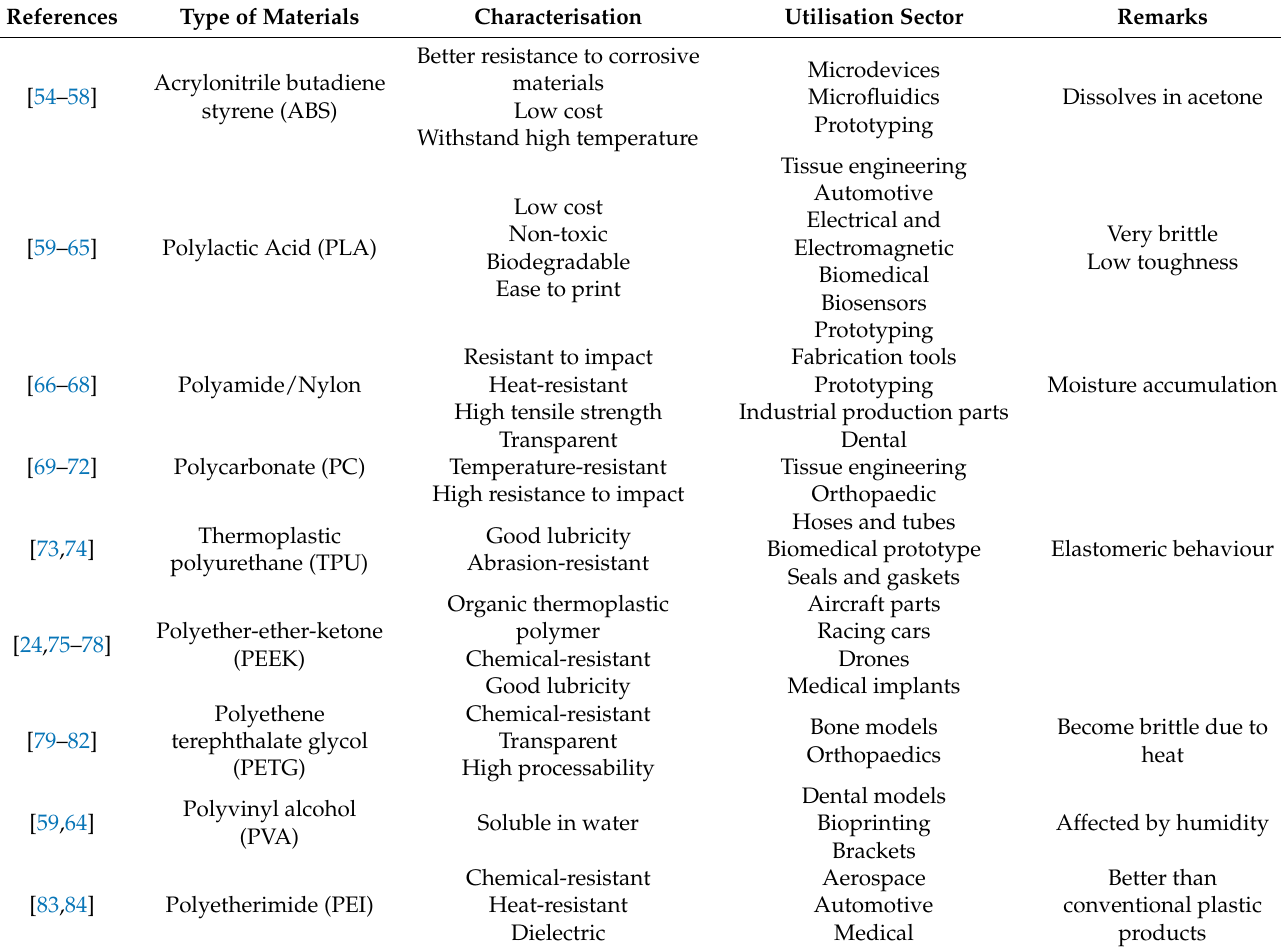
Table 1. Thermoplastic used in FDM